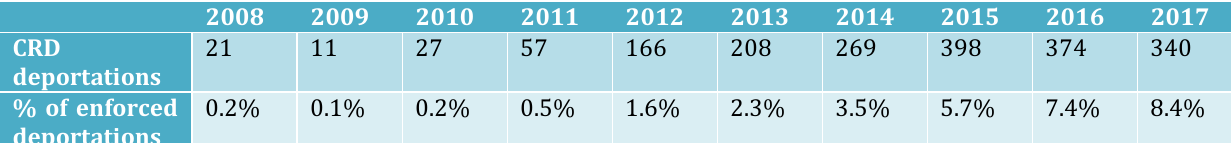
Table 1: Directive 2004/38/EC deportations enforced in Spain,